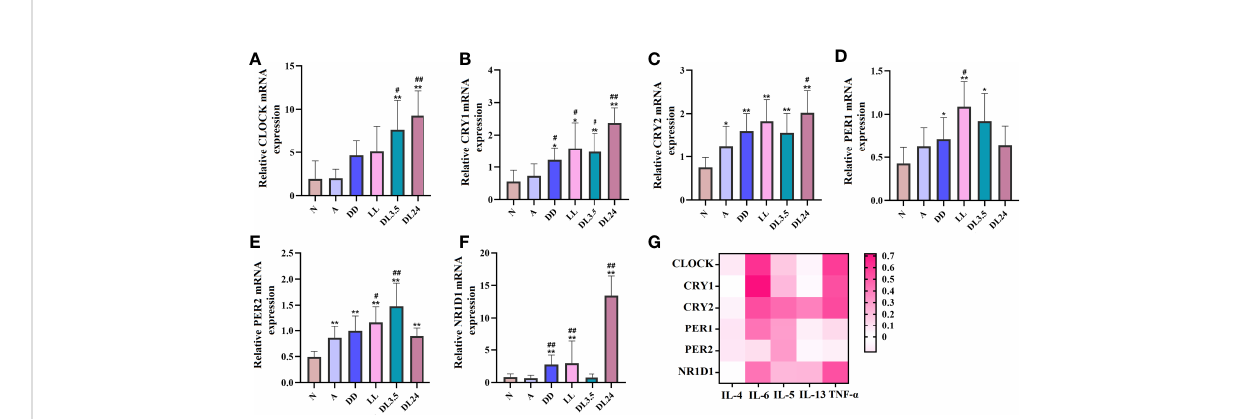
FIGURE 2 Association between circadian clock genes and in fl ammatory cytokines in mouse lung tissues. (A – F) RT-qPCR analysis of the mRNA levels of in fl ammatory cytokines (CLOCK, CRY1, CRY2, PER1, PER2, and NR1D1) in lung tissue. (G) Heat map of the matrix coef fi cient correlation of each circadian clock gene and in fl ammatory cytokines. The stronger Pearson ’ s correlation coef fi cients (r) are represented in red. N=control group; A=OVA group; DD=OVA + all-day darkness group; LL= OVA + all-daylight; DL3.5= OVA + 3.5 h dark/3.5 h light group; DL24= OVA + 24 h dark/ 24 h light group; BLAF= bronchoalveolar lavage fl uid. All data are presented as the mean ± SEM of 6 mice per group, * p < 0.05, ** p < 0.01, compared with the control group. # p < 0.05, ## p < 0.01 compared with the OVA group. One-way ANOVA with Tukey ’ s multiple comparison analysis method, Pearson ’ s correlation coef fi cient.